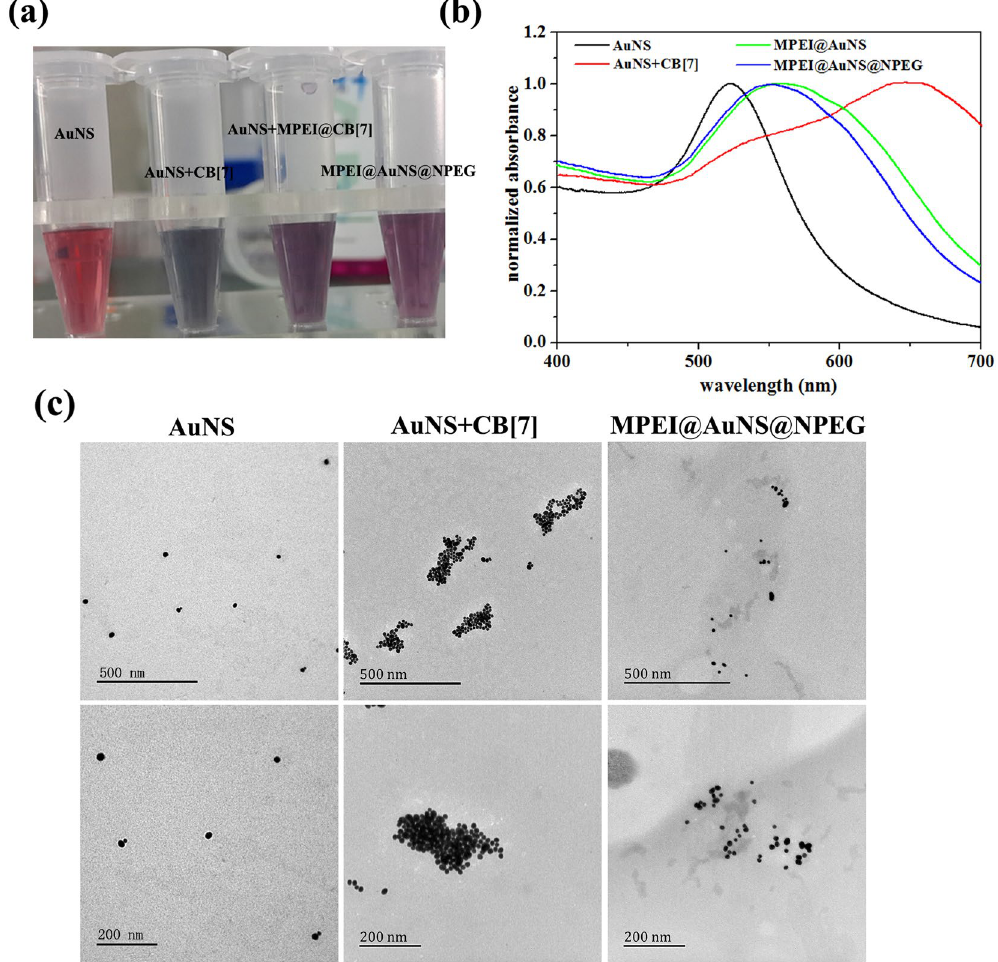
Figure 3. ( a ) Digital photos of AuNS, AuNS + CB[7], AuNS + MPEI@CB[7] and MPEI@AuNS@NPEG solution with the same AuNSs and CB[7] concentration after 2 h incubation; ( b ) UV-Vis spectra of AuNS, AuNS + CB[7], AuNS + MPEI@CB[7] and MPEI@AuNS@NPEG solution with the same AuNSs and CB[7] concentration after 2 h incubation; ( c ) TEM images of different